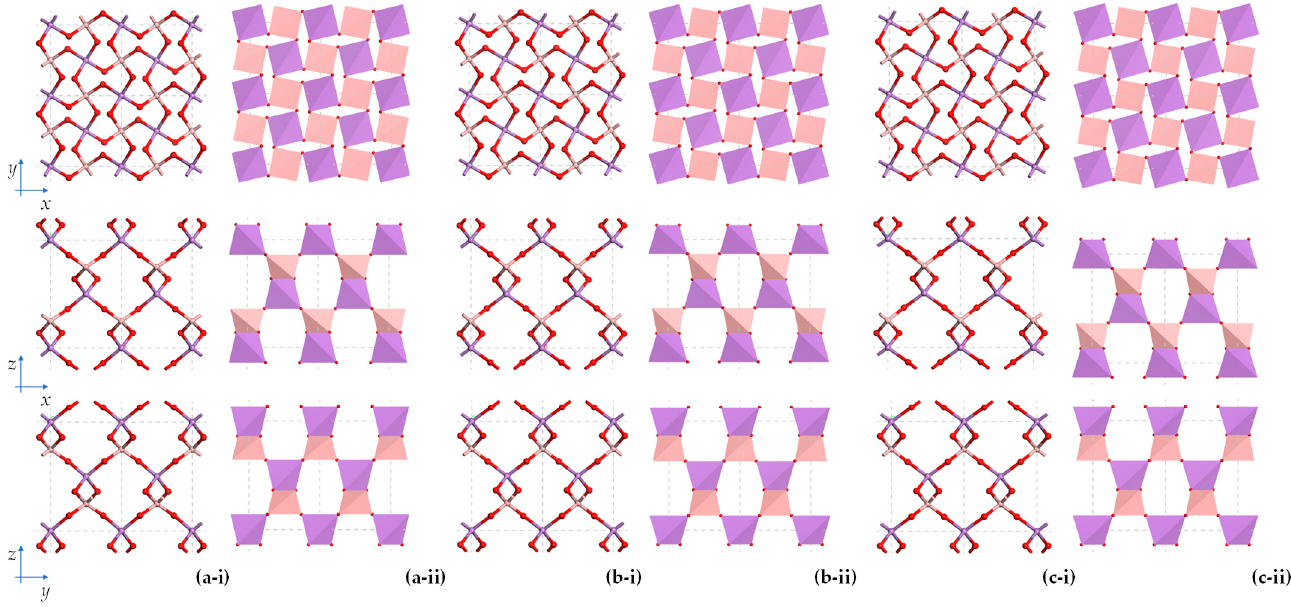
Figure 1 . Images of the structure of BAsO 4 at p = 1 Atm = 0.101 GPa depicted in terms of ( i ) atoms (spheres) and bonds (cylinders), and ( ii ) tetrahedra comparing the experimentally obtained crystal structure of BAsO 4 as obtained by ( a ) Shulze [2] and ( b ) Haines et al. [3] with that simulated using the DFT simulations, ( c ). Details of the protocol used for the simulations are outlined in Appendix A.